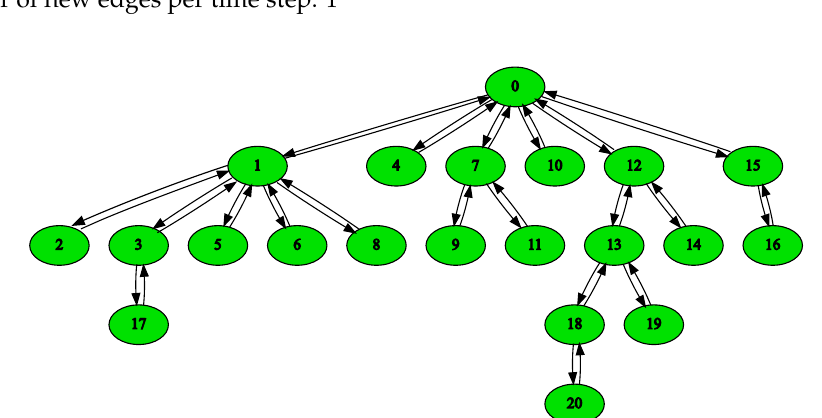
Figure 8 is an exemplary generated topology with the parameters: